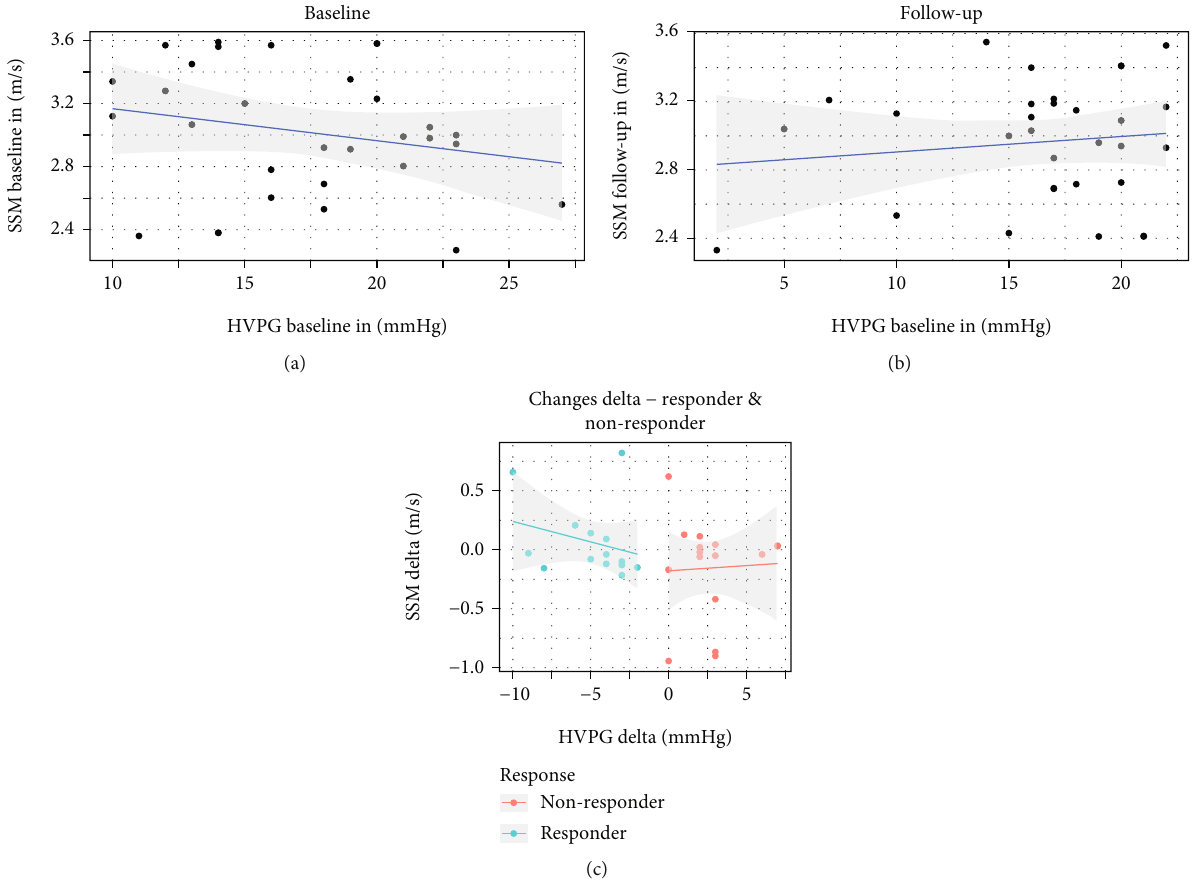
Figure 7: Results for spleen elastography measurement (SSM) and corresponding HVPG results: SSM results showed only a poor/no correlation with corresponding HVPG results in both baseline (a) and follow-up (b) investigations. Δ -HVPG and Δ -SSM values did not show any signi fi cant correlation both in response and non-response groups (c) (HVPG =hepatic venous pressure gradient; SSM =spleen sti ff ness